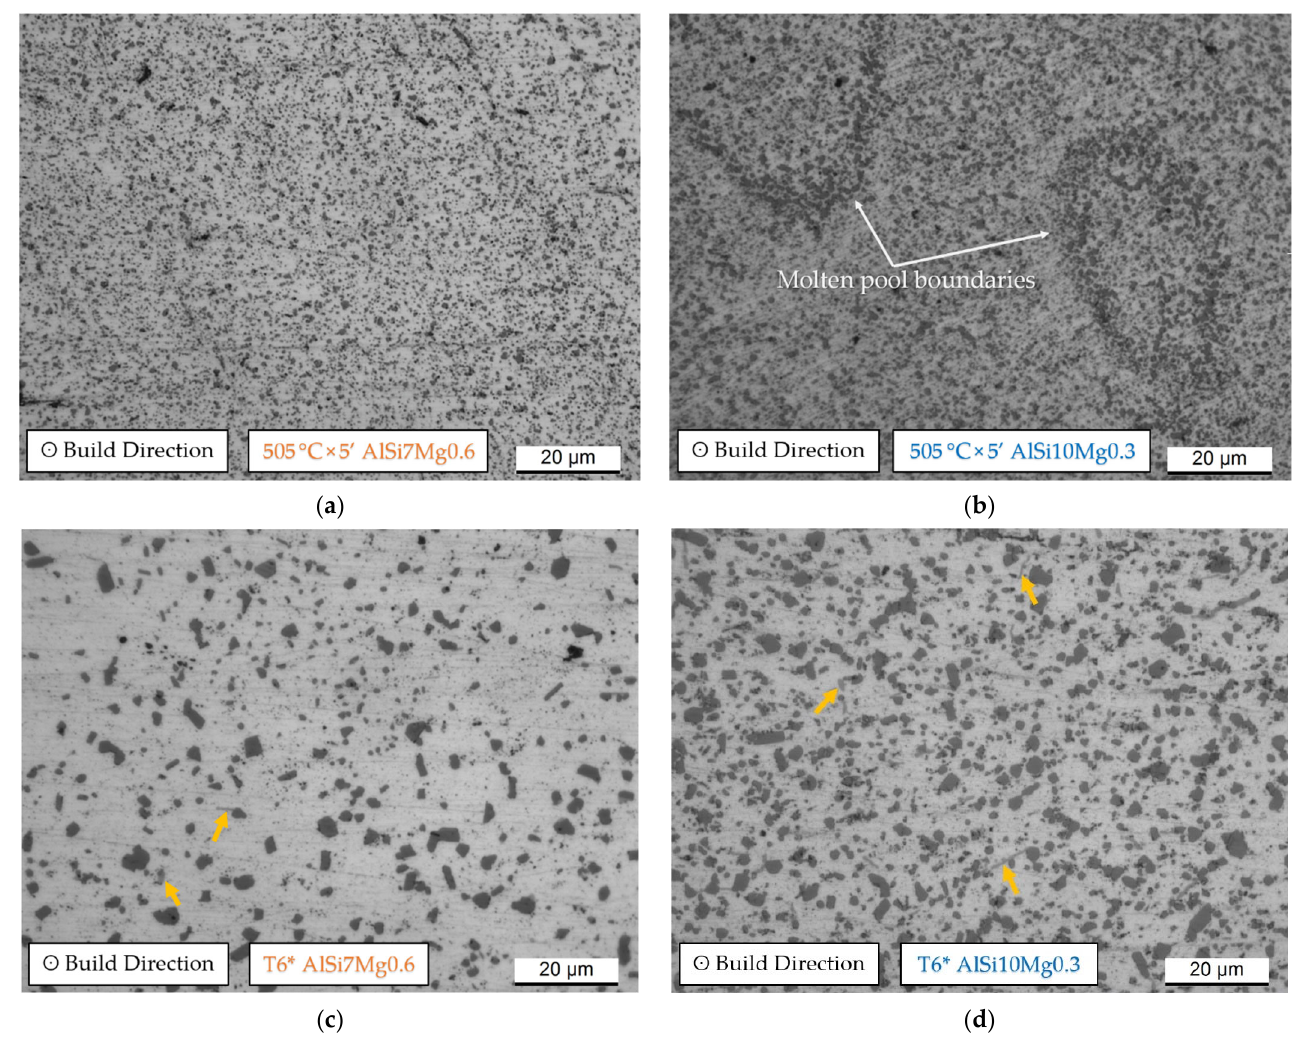
Figure 7. OM micrographs of the AlSi7Mg0.6 ( a , c ) and AlSi10Mg0.3 ( b , d ) microstructure after both the SHT at 505 °C × 5 ′ ( a , b ) and T6* ( c , d ). Orange arrows indicate different precipitates. Si ‐ eutectic particles were analysed in both the AlSi7Mg0.6 (Figure 8a,b) and All aging curves related to both AlSi7Mg0.6 (Figure 10a,b) and AlSi10Mg0.3 (Figure 8c,d) sample solutions, heat ‐ treated at 505 °C × 1 h, × 2 h and × 4 h, respectively. The statistical analysis related to the AlSi7Mg0.6 (Figure 8a) shows a dis ‐ placement of the equivalent diameters, ranging from 0.2–3.4 μ m (SHT 1h) to 0.2–5 μ m and 5.4 μ m for the SHT 2h and SHT 4h, respectively. At the same time, the Si particles per unit of area decrease from 0.076 to 0.043 ( μ m − 2 ) while the average equivalent diameter increases from 0.81 to 1.32 μ m. Despite the difference in holding time of 2 h at 505 °C between the red (SHT 2h, Figure 7b) and yellow (SHT 4h, Figure 8b) trends remain almost comparable except for the SHT 4h samples which show higher frequencies of Si ‐ eutectic particles hav ‐ ing equivalent diameters between 4.2 and 5.4 μ m. As a matter of fact, SHT 4h confers